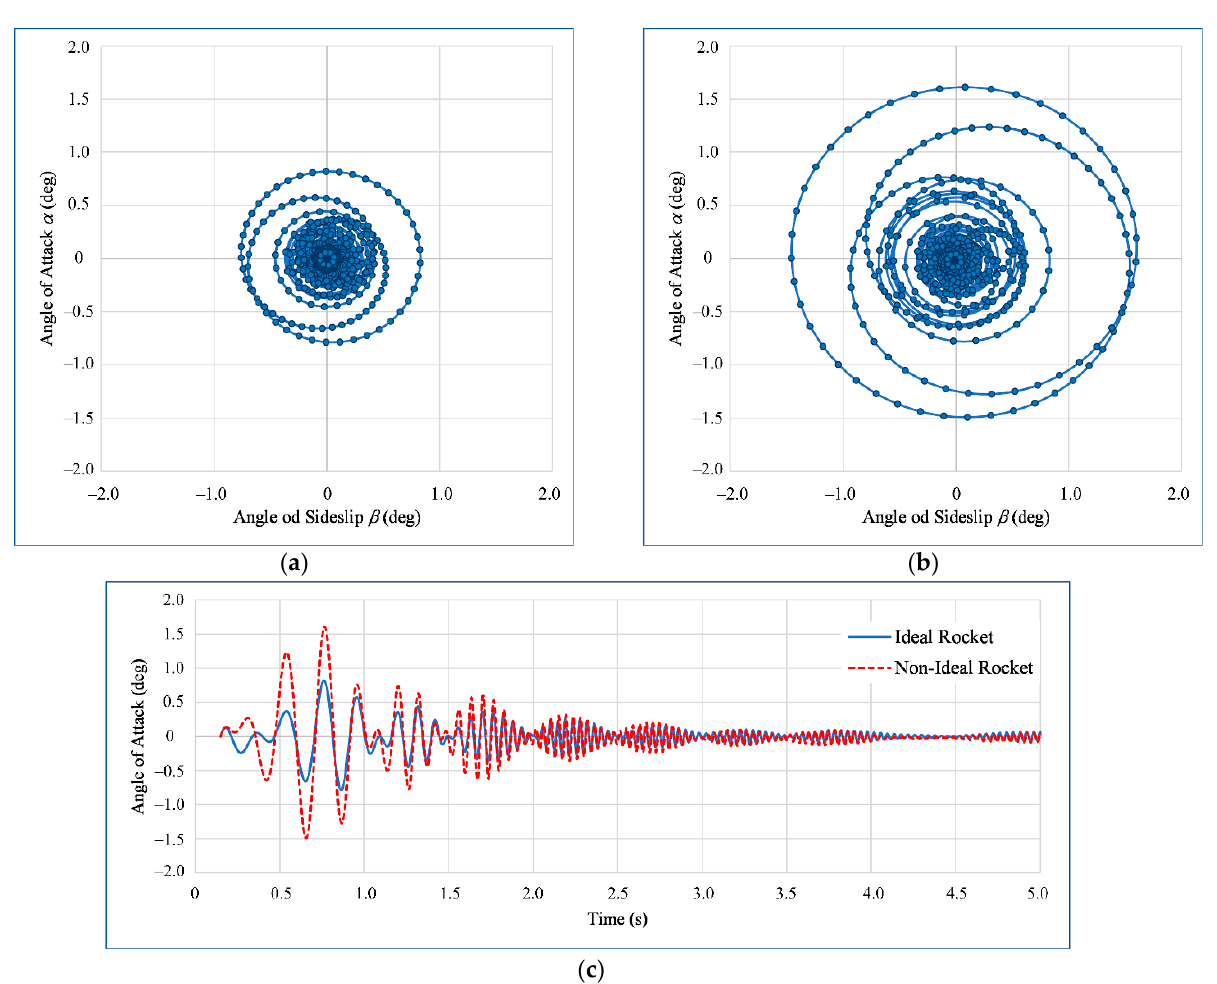
Figure 11. Comparison of the pitching and yawing motion for ideally ( a ), and non-ideally manufactured projectile ( b ), and the comparison of angle of attack for both projectiles ( c ).